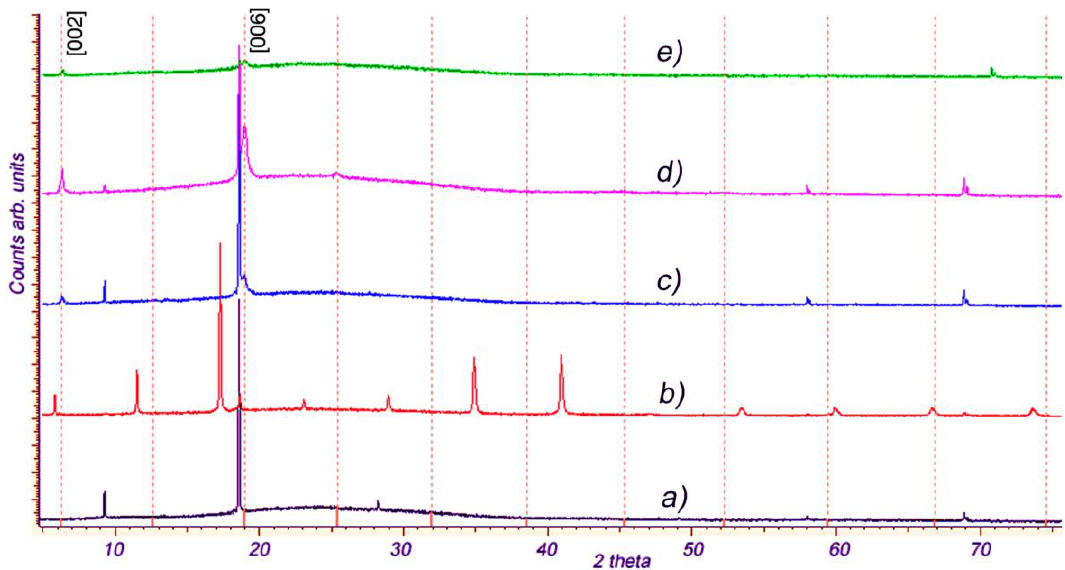
Figure 8. ( a ) XRD patterns for the pristine orthorhombic In 1.2 Ga 0.8 S 3 crystal, ( b ) In 1.2 Ga 0.8 S 3 ·0.5(p-AP) compound, and ( c – e ) p-EDA intercalated In 1.2 Ga 0.8 S 3